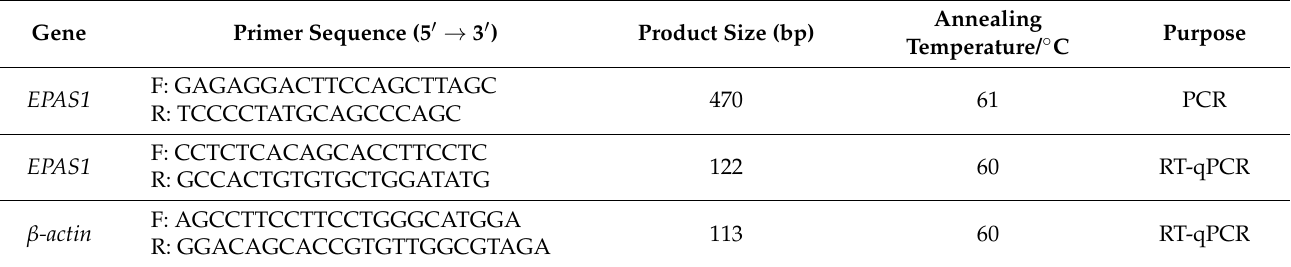
Table 1. Primers for PCR and